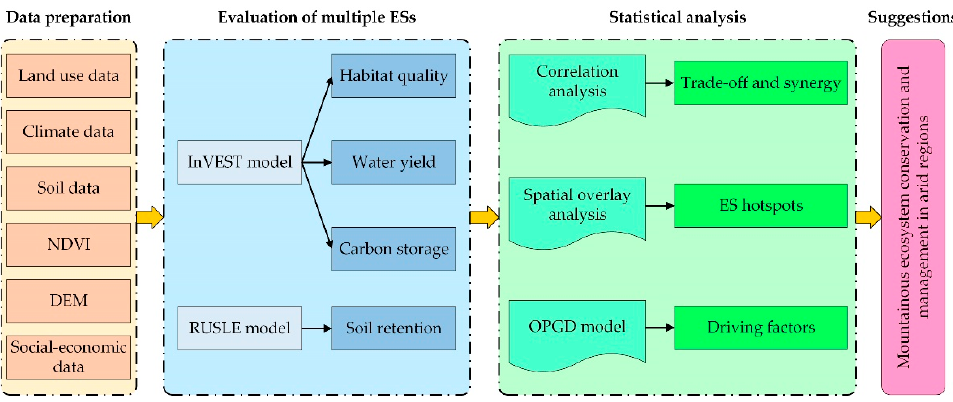
Figure 1. Research framework.